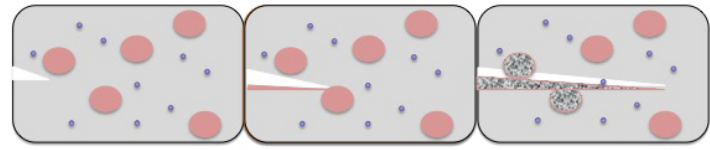
Figure 7. Self-healing in polymeric materials using the capsule-based